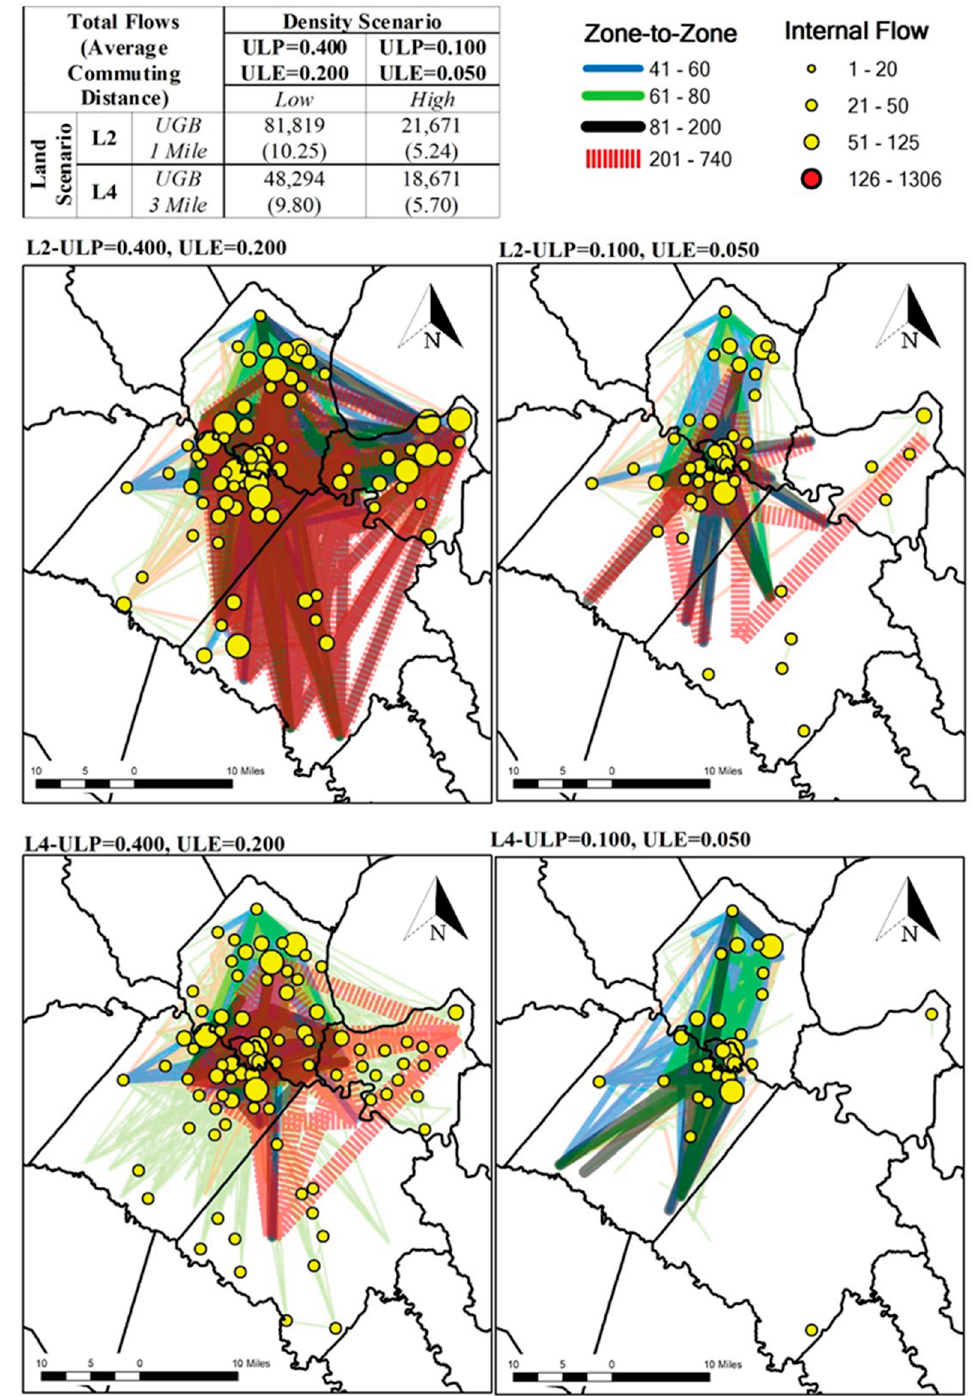
Figure 7. Optimal Zone–to–Zone Flows.